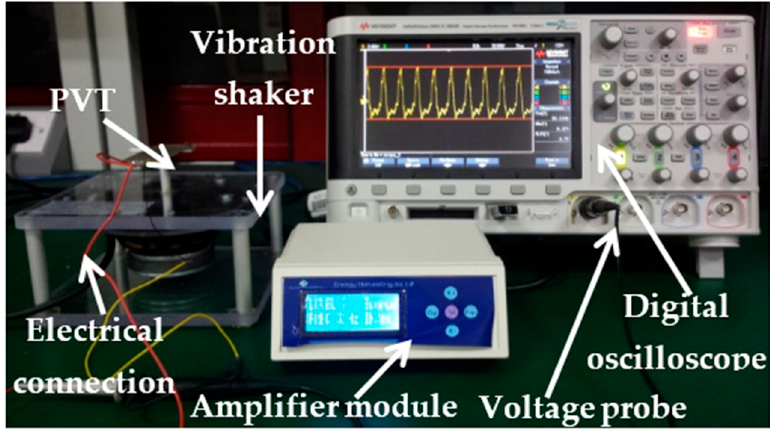
Figure 7. Experimental test bench layout.